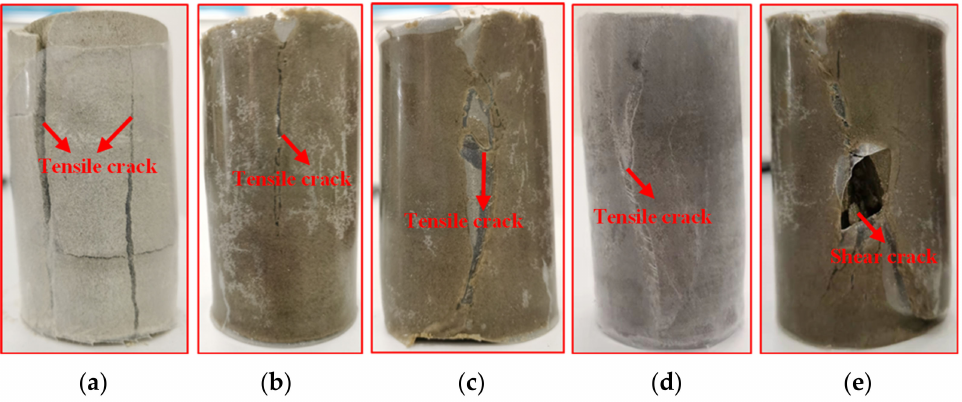
Figure 15. The morphology of sandstone samples after failure under fatigue loading. ( a ) σ 3 = 0 MPa; ( b ) σ 3 = 2.5 MPa; ( c ) σ 3 = 5 MPa; ( d ) σ 3 = 10 MPa; ( e ) σ 3 = 15